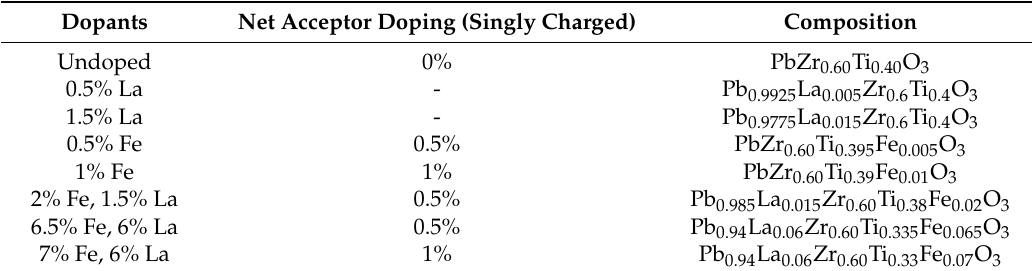
Table 1. Summary of lead zirconate titanate (PZT) samples investigated in this study. The amounts of dopant are given in mol % according to the perovskite formula. In the formula of the composition ionic compensation of donors is taken into account by cation